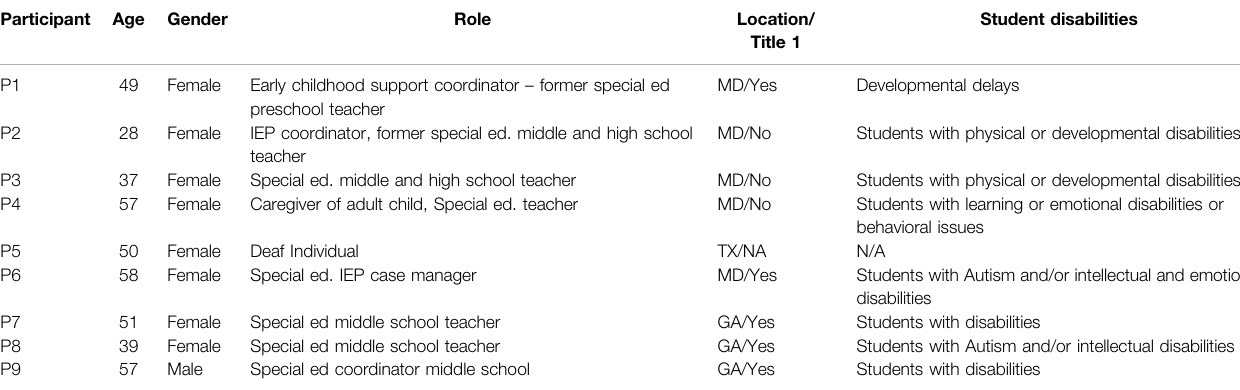
TABLE 1 | Participant demographic information (IEP: Individualized Education